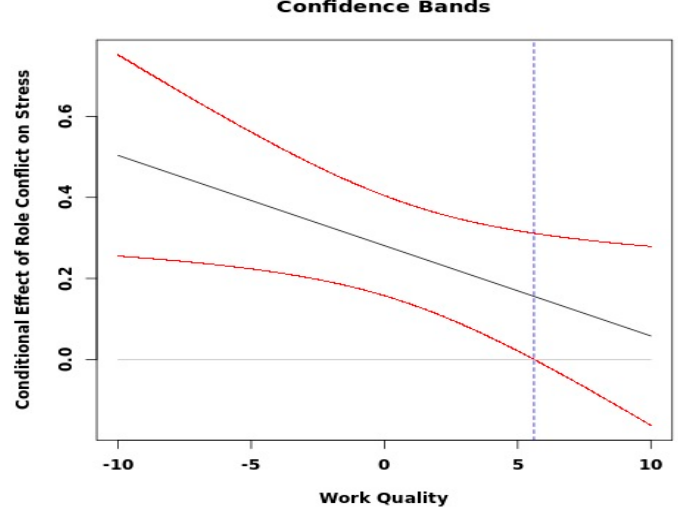
Figure 3. The conditional impact of role conflict on stress by staff-assessed care quality for dental nurses.